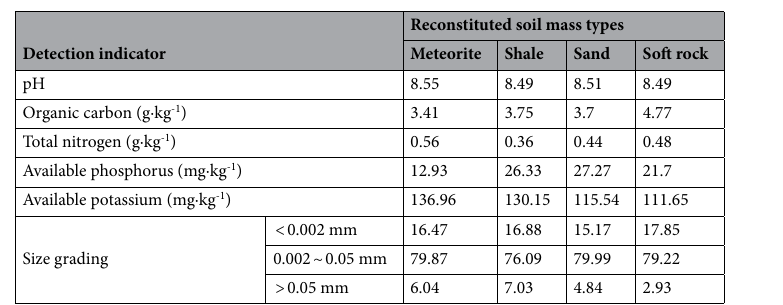
Table 1. Basic physical and chemical properties of four reconstructed soil at 0 ~ 20 cm